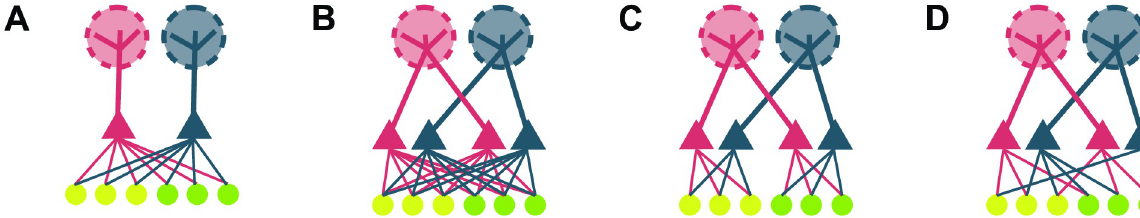
Fig 3. Sparsifying connectivity with sister cells. Each panel shows a schematic of the connectivity between mitral cells (triangles) and granule cells (circles). All connections are reciprocal. (A) Original scenario—no sister mitral cells. Connectivity is all-to-all, and the weights are A densely connected configuration where every granule cell connects to all sisters on each glomerulus, with weight W s receive the same number of connections as in panel A, but the granule cells receive twice as many as in panel A ( S times as as many in general). All- to-all connectivity is thus exacerbated. (C) Blocks of granule cells, indicated by the shades of green, connect to the same sister from each glomerulus, leading to maximally sparse connectivity. In this example, the first three granule cells connect to the first sister on each glomerulus, and the second three granule cells connect to the second sister; see Eq (17). Sister mitral cells now interact with a factor of 2 fewer granule cells ( S fewer in general), sparsifying mitral cell connectivity. (D) A more realistic maximally sparse connectivity pattern. Each granule cell connects to a single, randomly selected sister cell from each glomerulus; see Eq (18). Sister mitral cells connect to a factor of S fewer granule cells on average, though individual mitral cells may connect to more (like the first green mitral cell) or fewer (like the second).